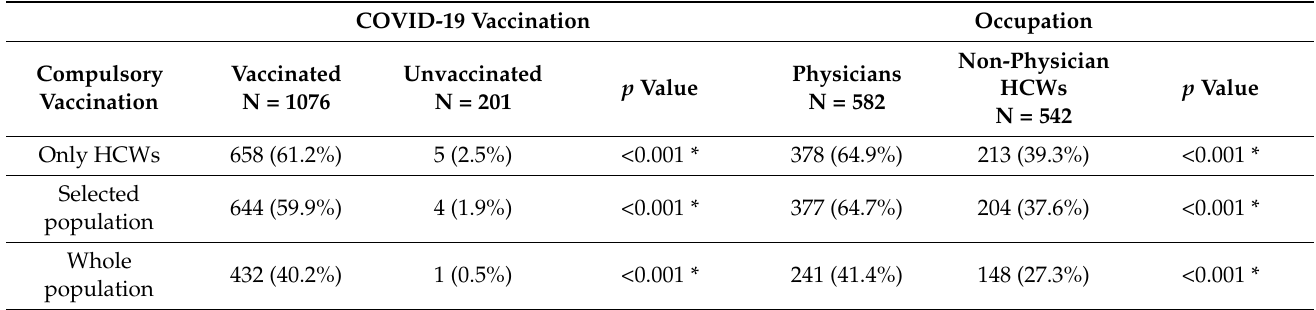
Table 4. Attitudes towards introduction of compulsory vaccination (N =